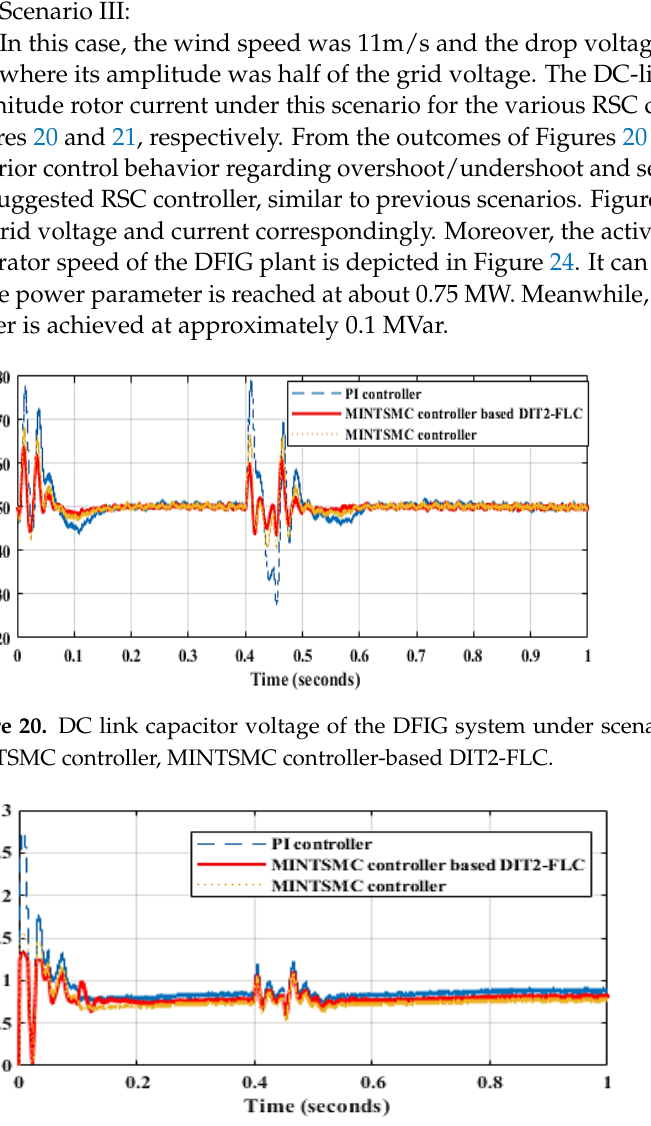
Figure 21. Magnitude rotor current of the DFIG system under scenario III via the PI controller, MINTSMC controller, MINTSMC controller-based DIT2-FLC.